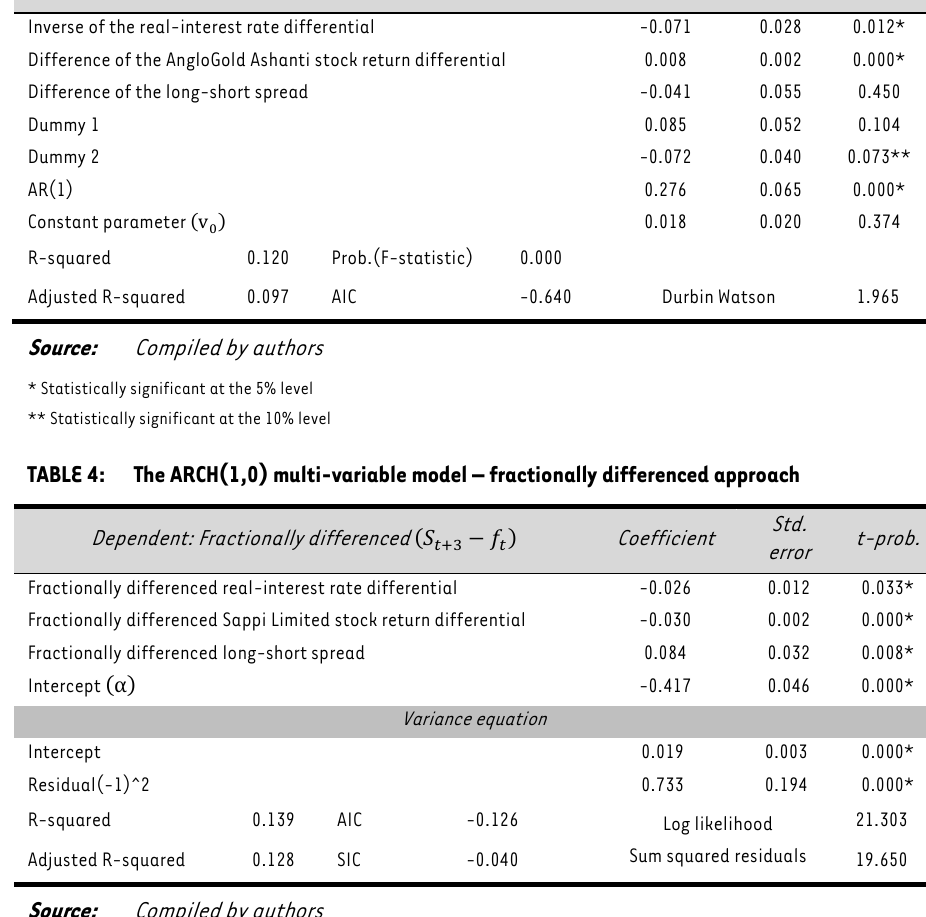
The multi-variable model (OLS) – first differenced approach Std. Dependent: Difference of Coefficient t-prob. Error Inverse of the real-interest rate differential -0.071 0.028 0.012* ( 𝑆 𝑡+3 − 𝑓 𝑡 ) Difference of the AngloGold Ashanti stock return differential 0.008 0.002 0.000* Difference of the long-short spread -0.041